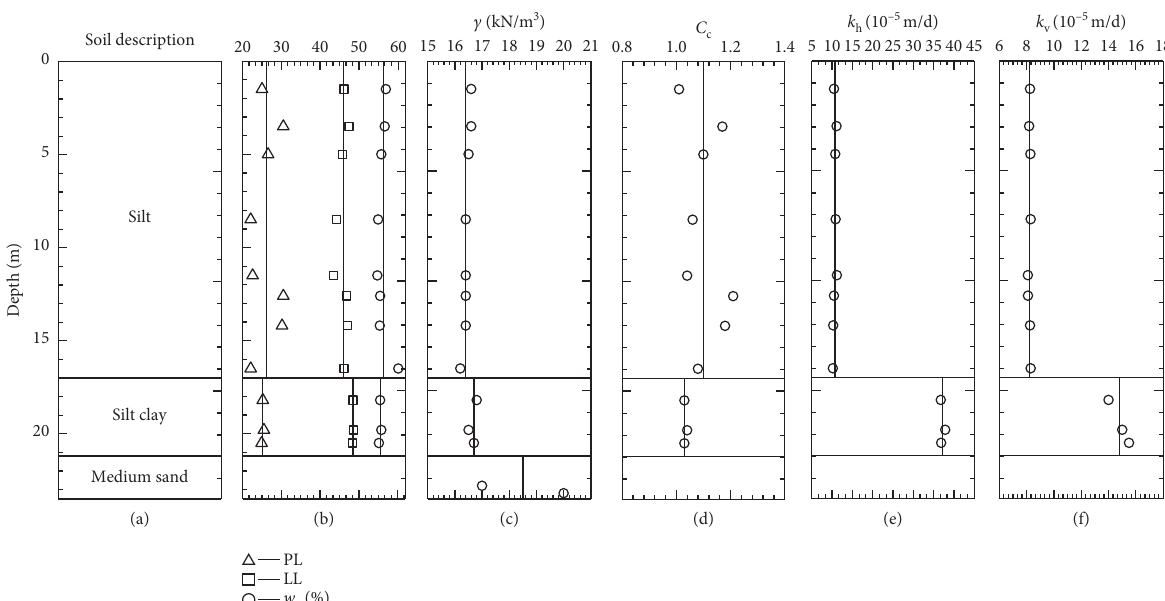
Figure 4: Soil profile and properties of the K53 +787 construction section. Note: PL : plastic limit; LL: liquid limit; w weight; C c : compressive coefficient; k